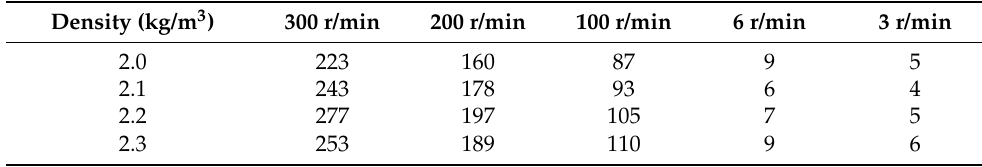
Table 4. Rheology of cement slurries with different